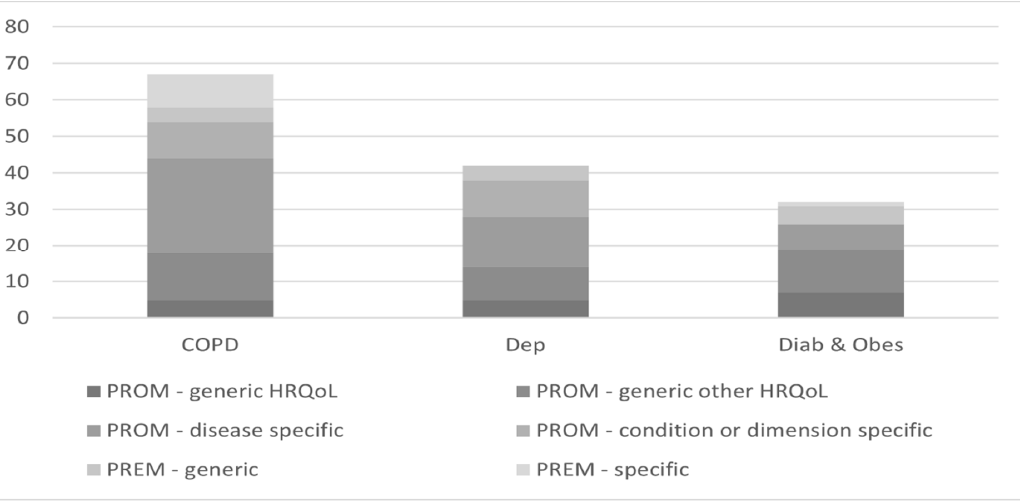
Figure 3. Number of PROMs and PREMS in studies by year of publication.